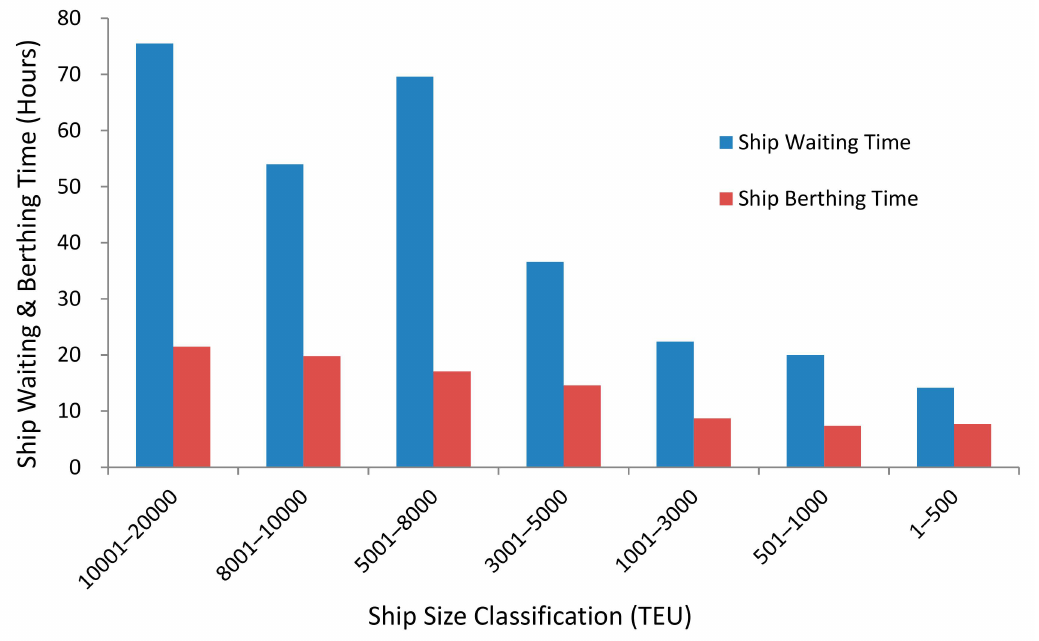
Figure 4. Average Ship Waiting Time and Berthing Time Based on Ship Size